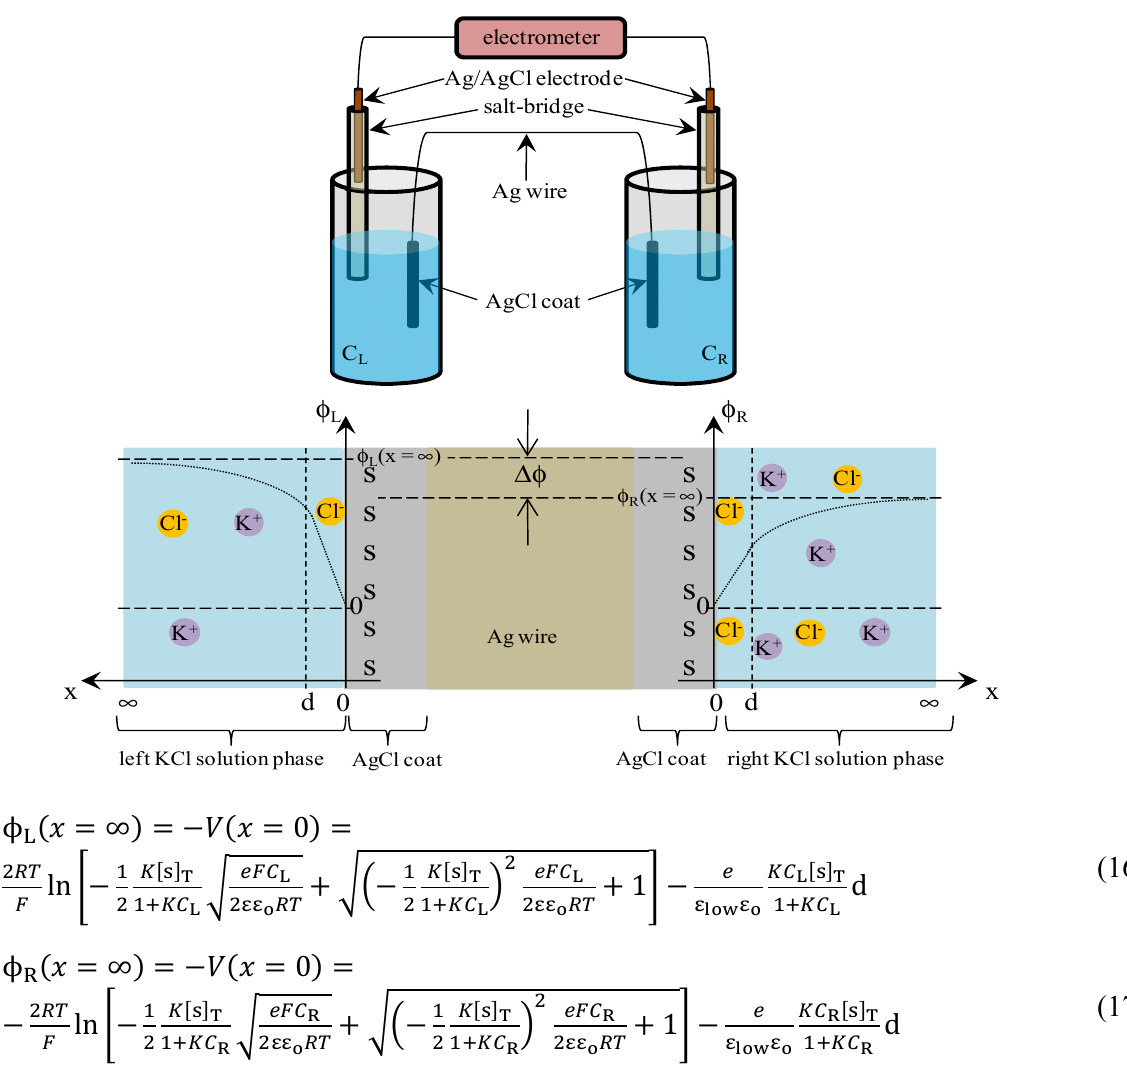
Figure 5. Graphical correspondence between experimental setup and adsorption